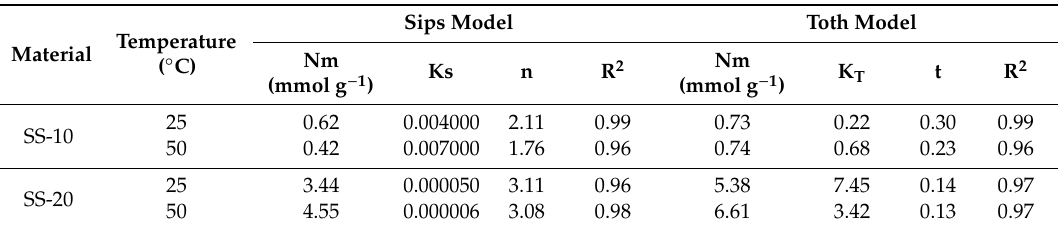
Table 7. The Sips and Toth parameters for CO 2 isotherms at 25 and 50 ◦ C. Sandstone impregnated at a mass fraction of 10% (SS-10) and 20% (SS-20) of